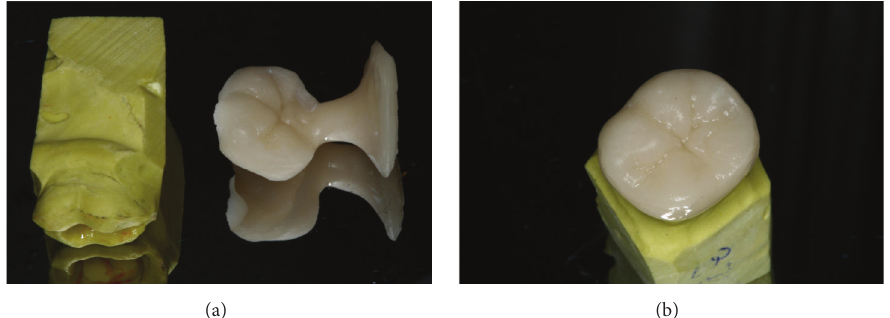
Figure 5: A pressed endocrown (VITA-PM9) with (a) and without (b) the attached sprue is positioned with the master mold.